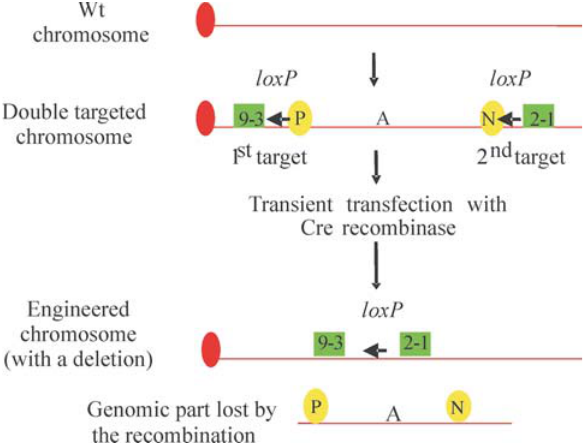
Figure2 -Basicstepsforchromosomeengineeringinmice.Asystempre- viously described(Ramirez-Solis et al ., 1995; Zheng et al ., 1999) for gen- erating defined chromosomal rearrangements is represented. Briefly, the methodutilizestwomousegenomiclibraries,the5’ hprt libraryand3’ hprt library, containing in each vector backbone one loxP site (black arrow), one half of the Hprt minigene, exons 1-2 or exons 3-9, respectively (green boxes), and a resistance marker for selection, Neomycin (N) or Puromycin (P), respectively (yellow circles). When targeted in the mouse genome the two serially inserted loxP sites can be recombined by Cre recombinase, and the Hprt minigene is reconstituted so that cells with rearranged chro- mosomes can be selected in HAT media. In this figure one particular chro- mosome is represented by a red line, and a circle depicts the centromere. The letter A represents a specific region of the chromosome between the two loxP sites, that will be lost by the recombination mediated by Cre recombinase. For simplicity, the insertion for both loxP sites is repre- sented in Cis and in direct orientation, but several integration alternatives are possible (see